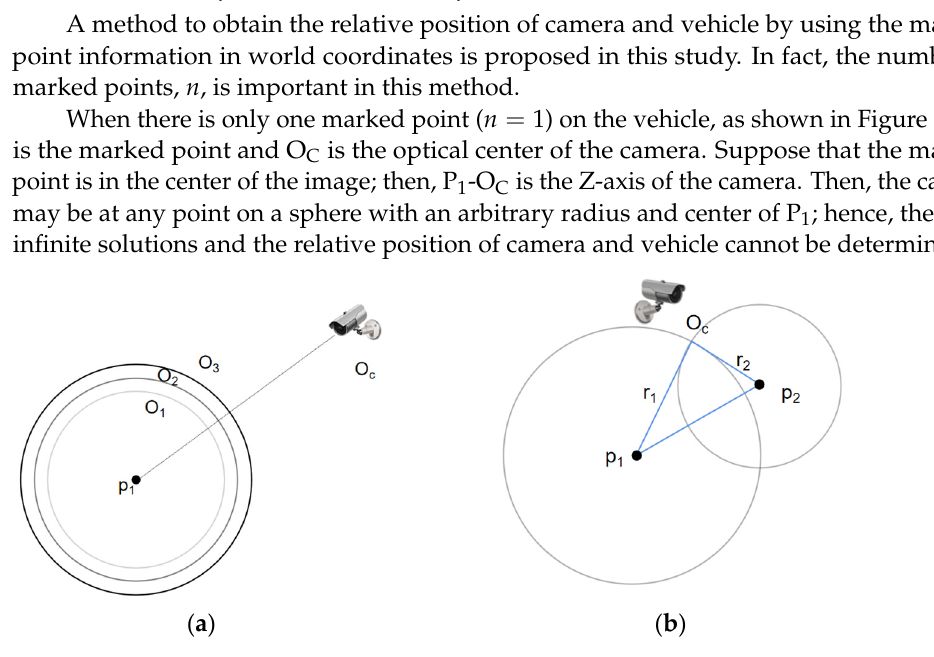
Figure 5. ( a ) Relative position of the camera and vehicle ( 𝑛 = 1 ). ( b ) Relative position of the camera and vehicle ( 𝑛 = 2 ).